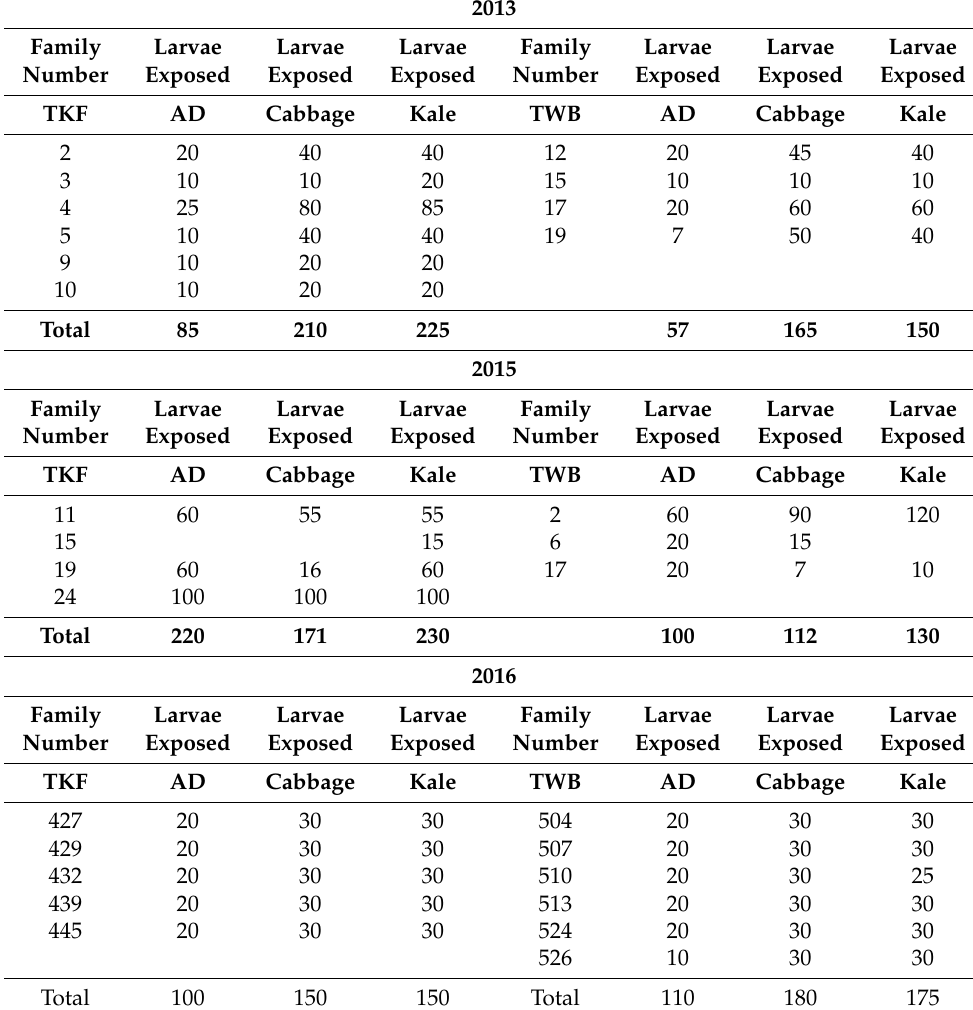
Table 4. Helicoverpa armigera single pair matings (moth families) of the Toowoomba strain (TWB3) and cabbage selected strain (TKF) that produced enough fertile eggs to run assays for each assessment (moth family number is arbitrary) in 2013, 2015 and 2016, showing the initial number of first instars larvae exposed to each diet type (AD = artificial diet). Divide the number by 10 to obtain the number of Petri